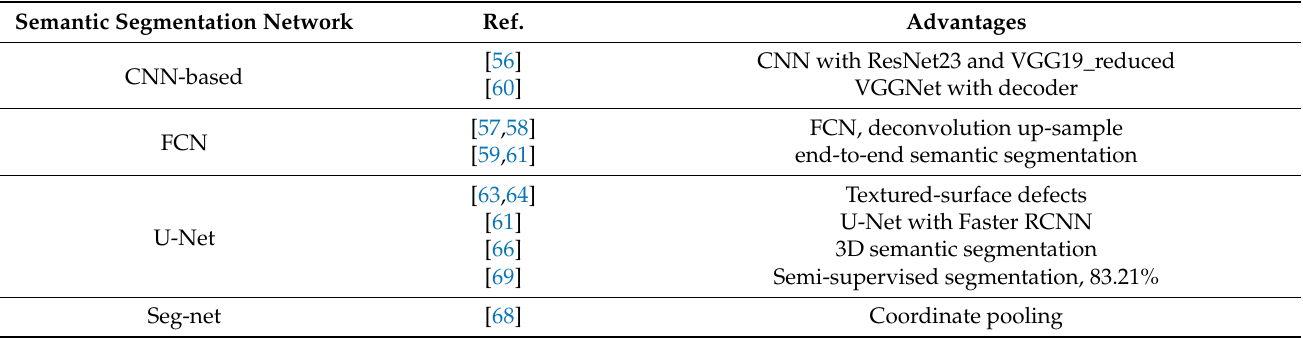
Table 3. Summary of semantic segmentation.